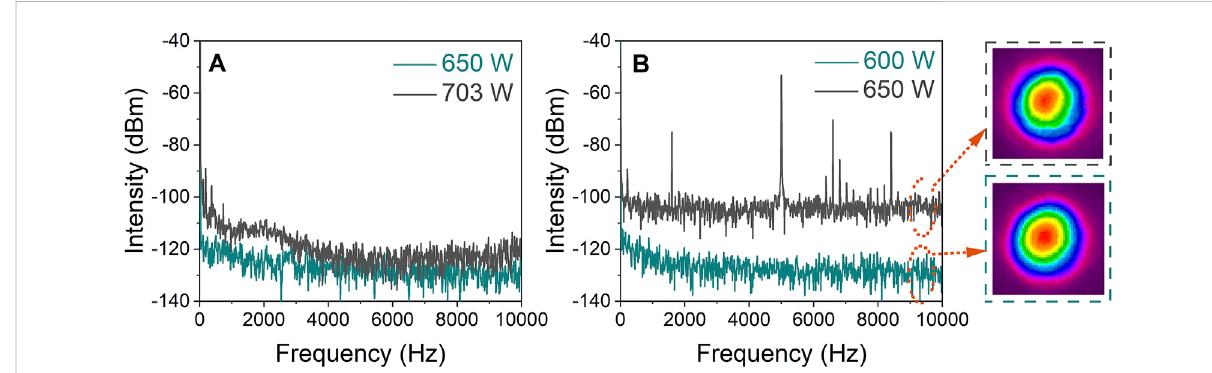
FIGURE 3 Fourier transform spectra of the temporal laser intensity (A) at the output power of 650 and 703 W with a laser seed PER of 4.3 dB, (B) at the outputpowerof600and650 WwithalaserseedPERof6.8 dB.Insets: Correspondingbeampro fi lesrecordedatlaserpowerof650 W(surrounded by gray dotted line) and 600 W (surrounded by green dotted line) with a laser seed PER of 6.8